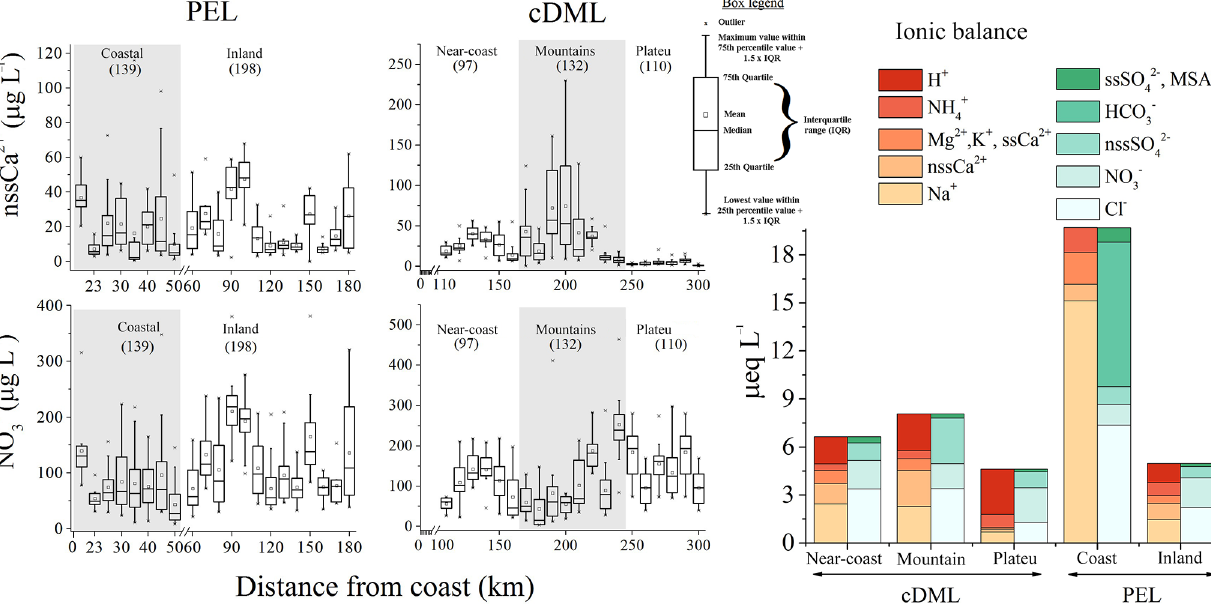
Figure 3. Distribution of nssCa 2 + and NO − concentrations in snow cores along PEL and cDML transects. The numbers inside brackets 3 indicate the total number of samples in respective sections. The balance of ions from all regions are denoted on right